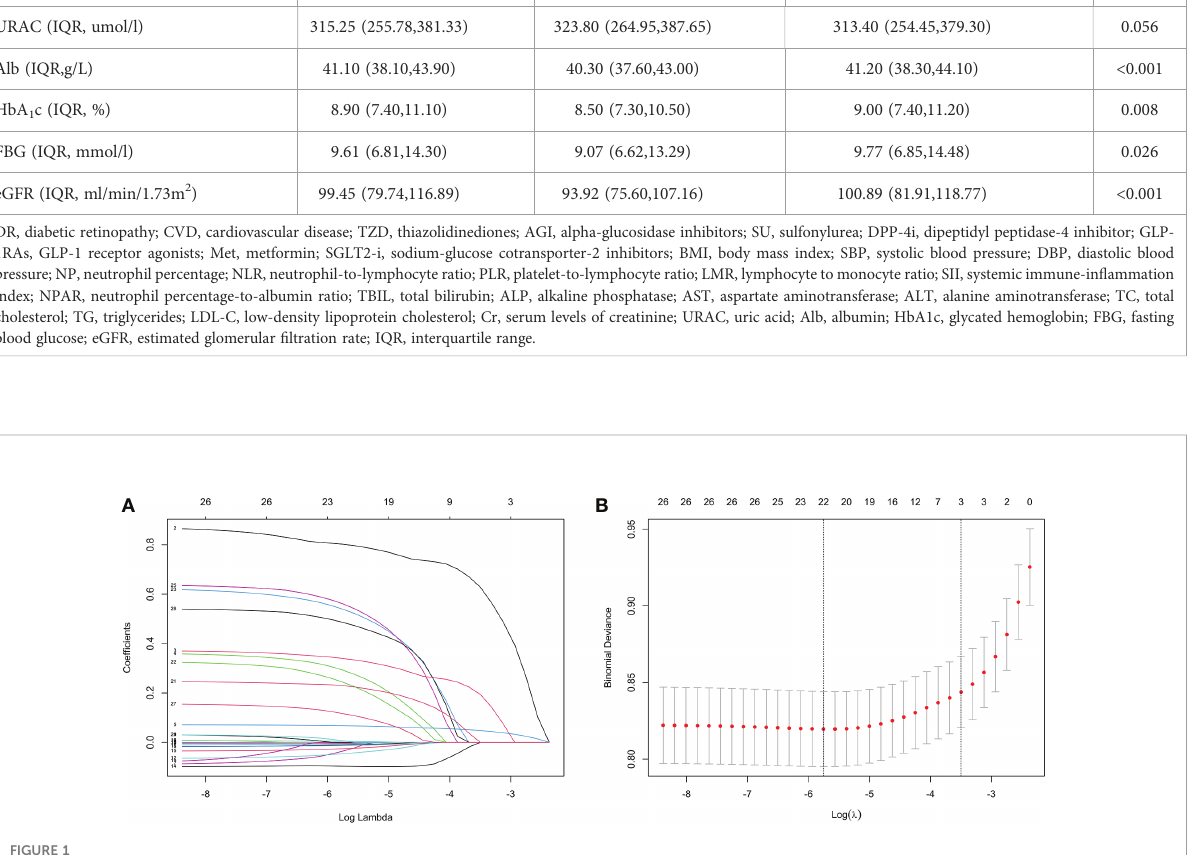
compared using Delong test (Table 5). Logistic regression